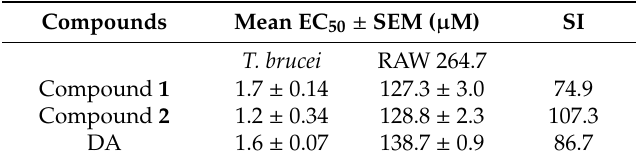
Figure 3. Dose-response curves of compounds. The dose-response curves and corresponding half-maximal e ff ective concentration (EC 50 ) values for DA ( A ), compound 1 ( B ) and compound 2 ( C ) were modeled from a non-linear regression analysis using the Hill function. Error bars were calculated from triplicate values. DA = diminazene aceturate; HC = hill coe ffi cient; dotted vertical line = concentration of maximum growth inhibition of T. brucei . Table 2. Antitrypanosomal activities and selectivities of